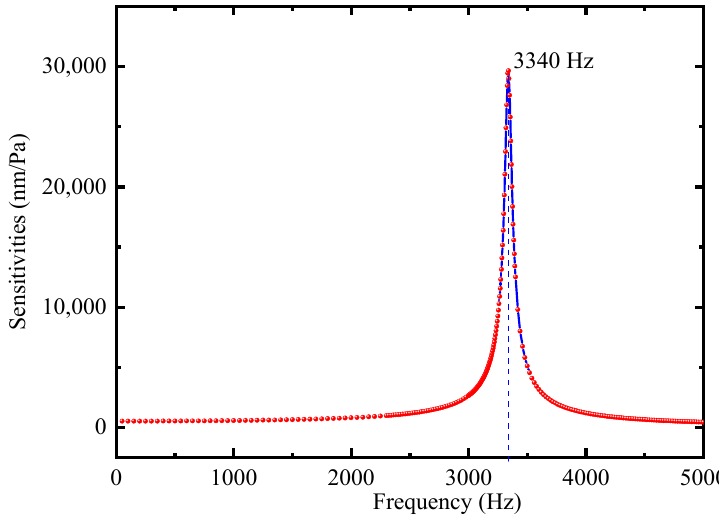
Figure 3. Simulation of the frequency response.